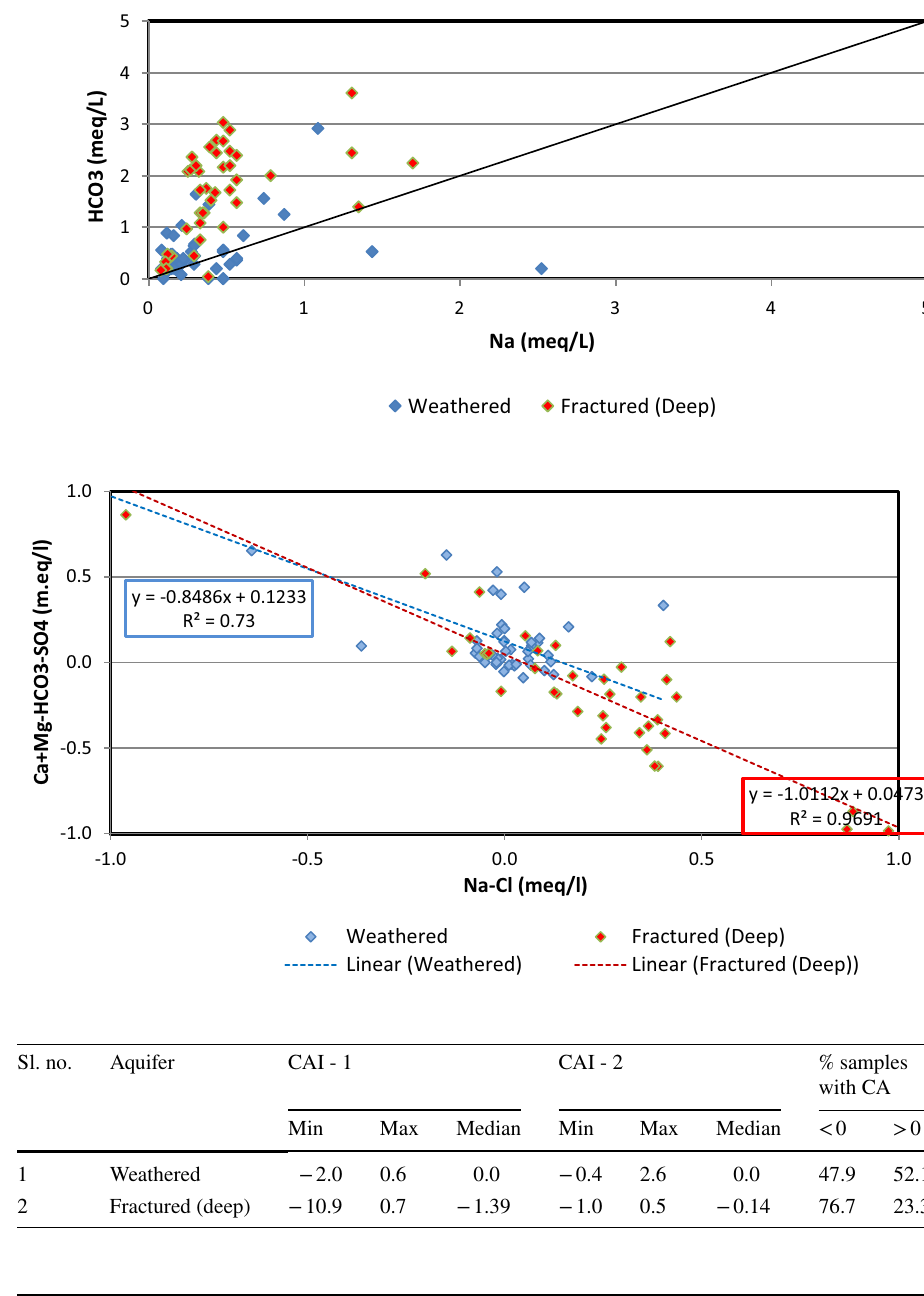
Fig. 11 Plots of Na versus HCO 3